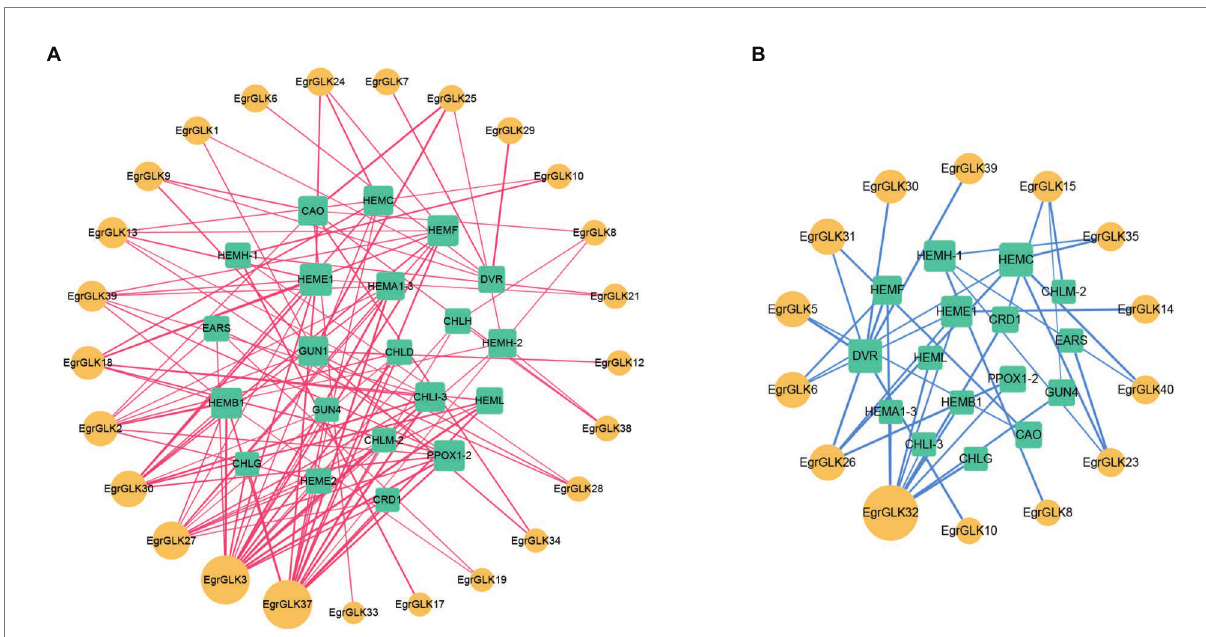
FIGURE 9 Co-expression network of EgrGLK genes and chlorophyll synthesis related genes. Positive correlation network (A) and negative correlation network (B) between EgrGLK genes and chlorophyll synthesis related genes. Circles represent EgrGLK genes, squares represent chlorophyll synthesis related genes, and the size of the circle or square represents the number of relationships between genes.